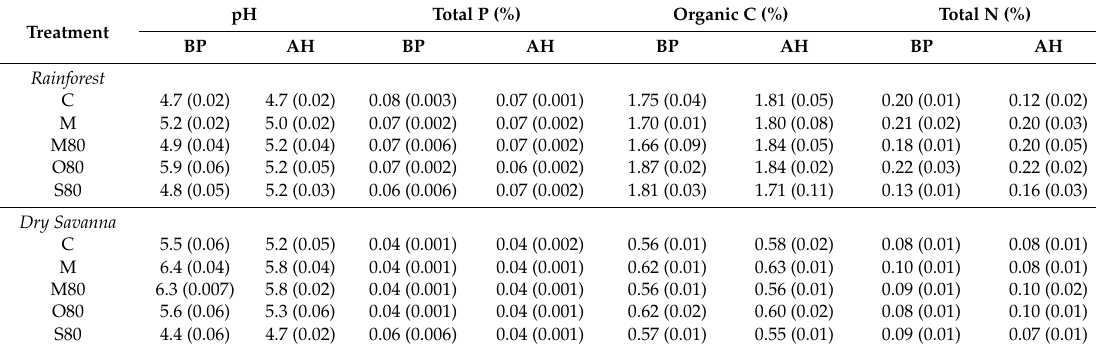
Table 1. Carbon content, pH, total phosphorus and total nitrogen concentrations of soil samples by ecoregion and treatment. Values are Mean (standard error). (n = 3). C = control, M = manure treatment, N / ha without any vegetables. BP = Before planting, AH = After harvest.